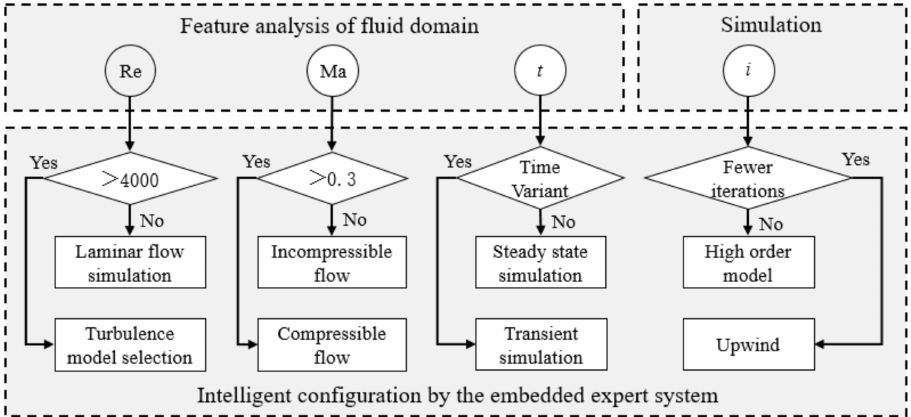
Figure 3. Intelligent model selection